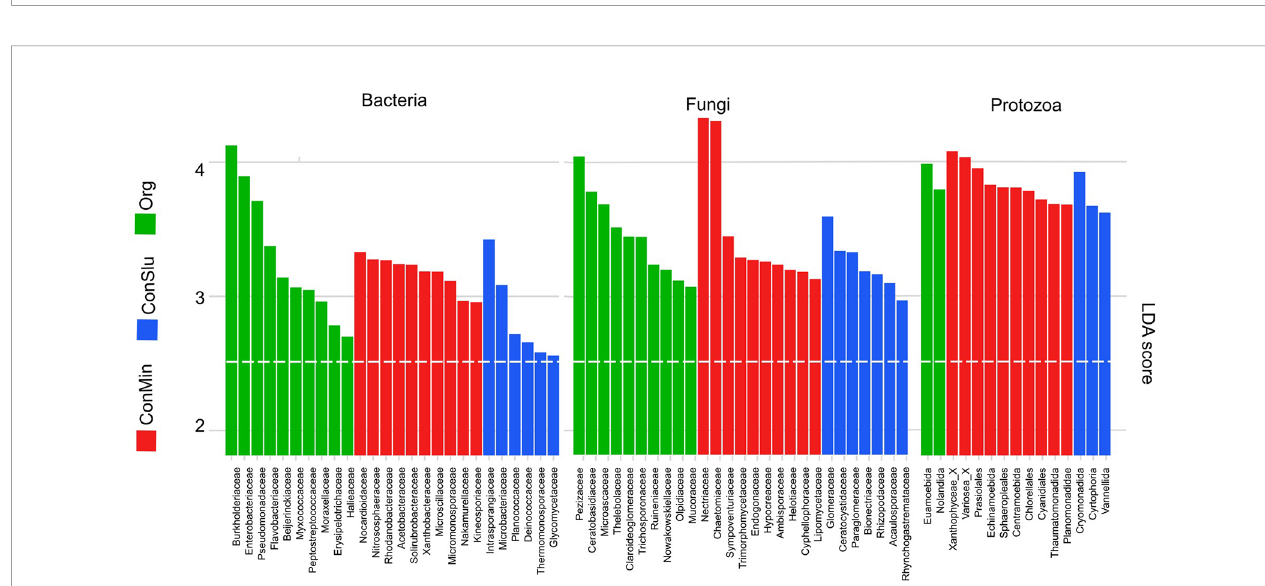
FIGURE 4 | Discriminant active bacterial, fungal, and protozoan taxa in the rhizosphere indicated by LEfSe analysis (LDA threshold of 2.5) resulting from distinct soil management types at location Vredepeel: ConMin (red), ConSlu (blue), and Org (green). LEfSe, linear discriminate analysis effect size; LDA, linear discriminate analysis.